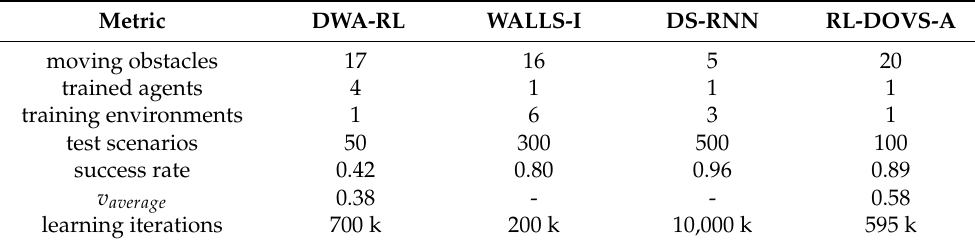
Table 7. Comparison with the best results of other methods. In the training environments and test scenarios, the initial and goal locations, obstacle velocities and the number of static and moving agents were randomly